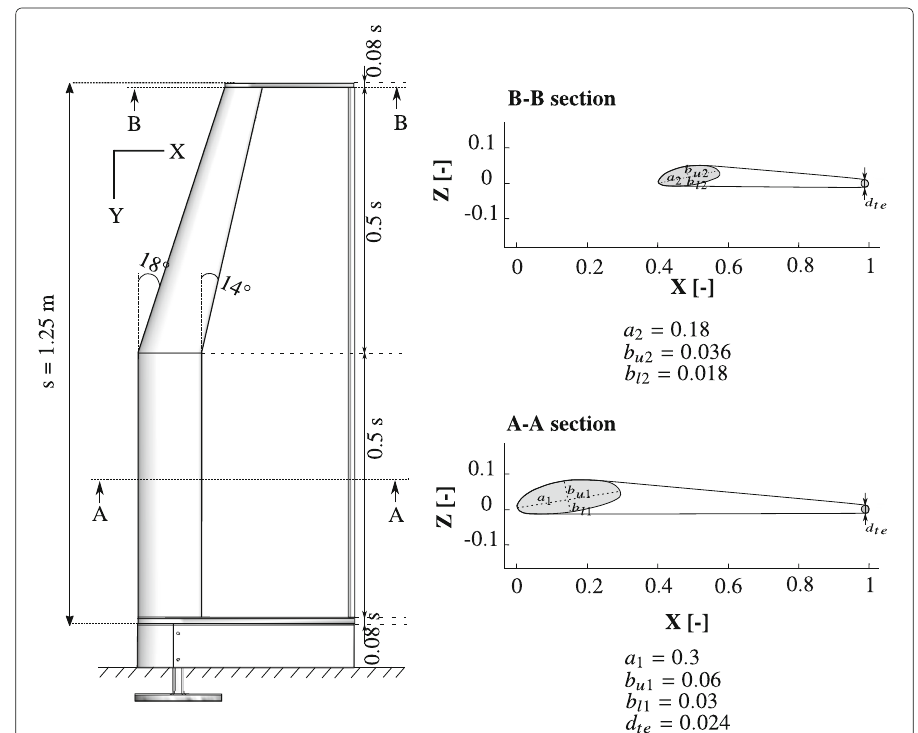
Fig. 1 Three dimensional elasto-flexible membrane wing model with geometrical